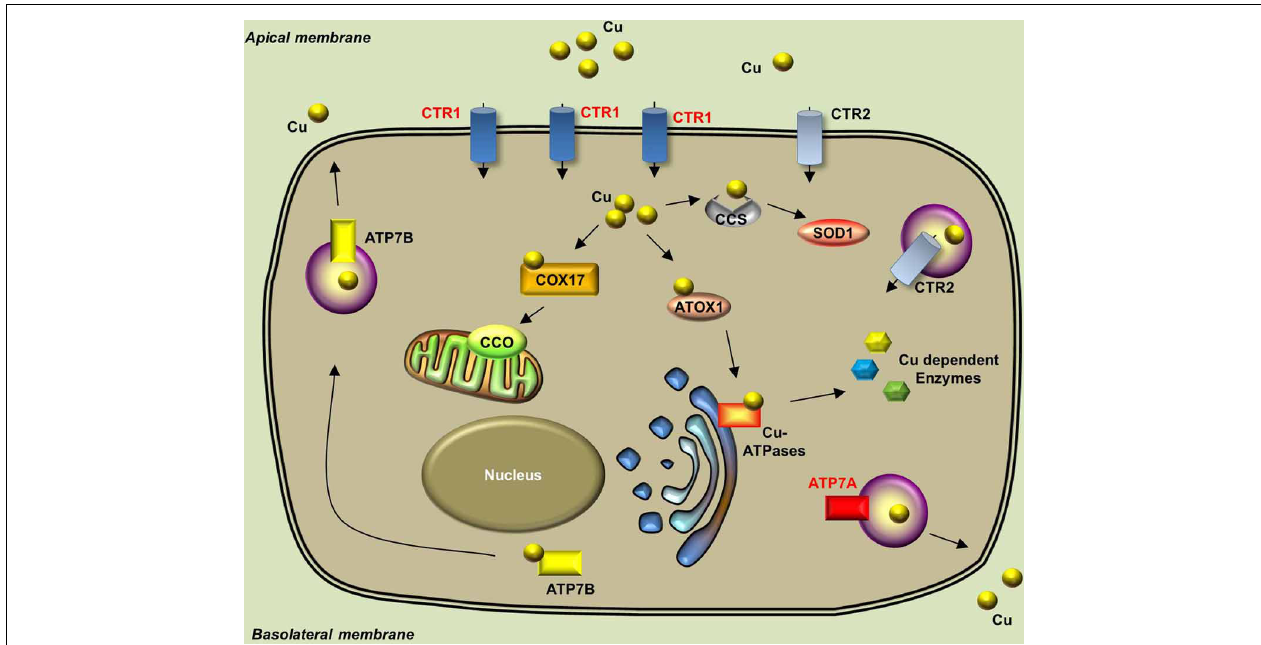
FIGURE 3 | Generalized overview of copper metabolism in vertebrate cells. Extracellular copper enters the cell through the high-affinity CTR1 receptor. The CTR2 receptor primarily mediates the release of copper from intracellular vesicles, but is also expressed in low levels in the plasma membrane. Intracellular copper is bound by a variety of copper chaperones and transported to various proteins in the following